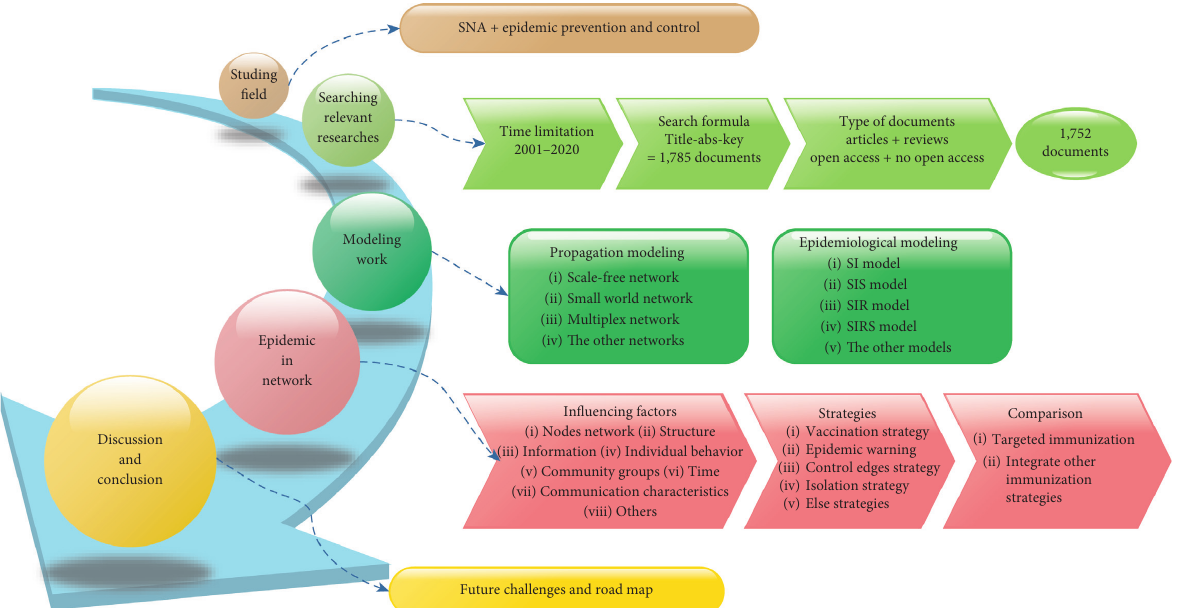
Figure 1: Article flowchart of the structure of this article. This review consists of 6 parts: Introduction, Approach to Literature Review, Modeling Work, Epidemic Research Based on Social Networks, Future Challenges and Road Map, and